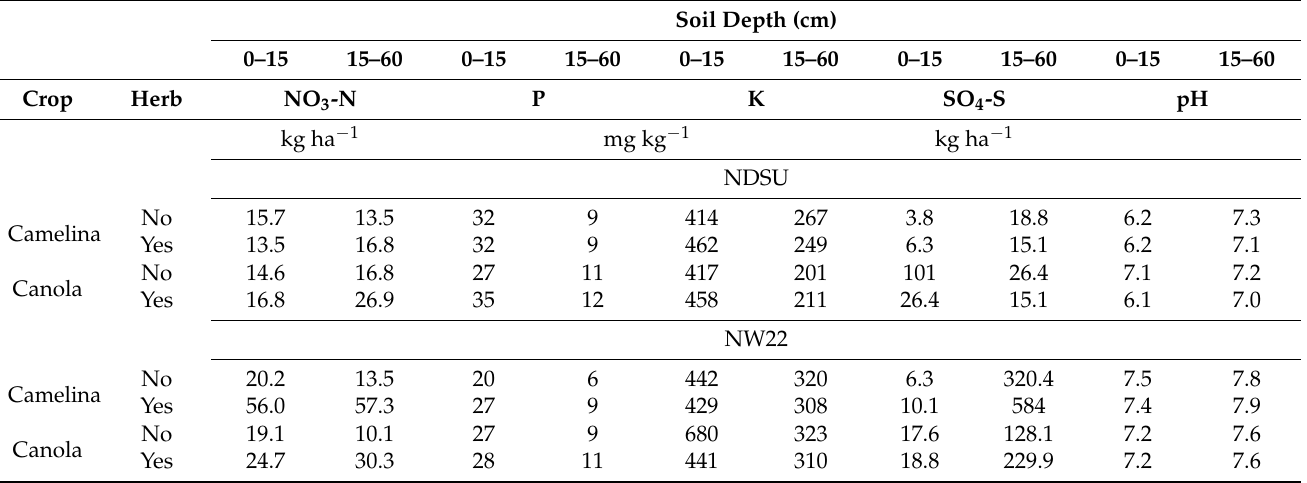
Table 3. Analysis of late season (27 July 2020) soil tests at 0–15 cm and 15–60 cm for nitrogen (NO 3 -N), phosphorus (P), potassium (K), sulfur (SO 4 -S), and pH at two locations (NDSU and NW22). Samples were pooled from all four replicates of sulfonylurea-resistant camelina or canola treated with (Yes) or without (No) herbicide (Herb) at each